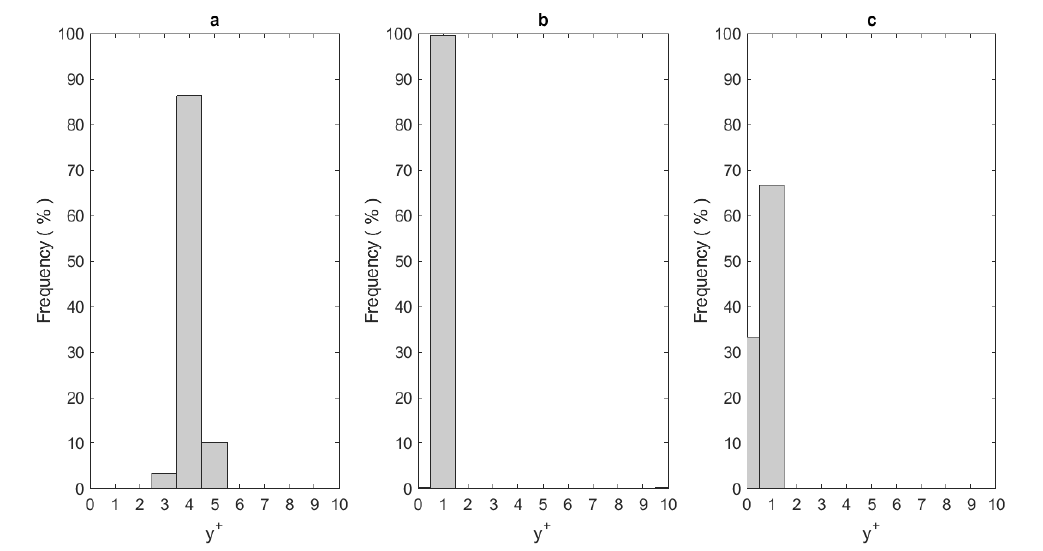
Figure 5. y + distribution along the computational domain for the turbulent numerical simulation using water (Re = 45 × 10 3 ) with: Grid 1 ( a ); Grid 2 ( b ); and Grid 3 ( c